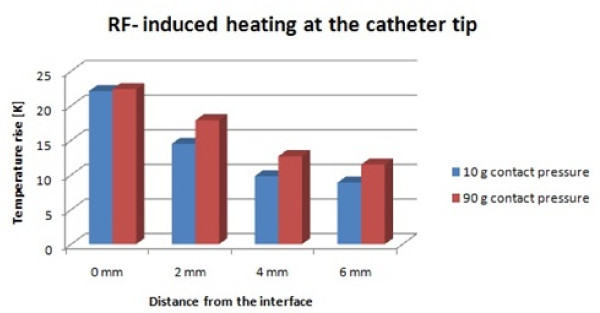
MR-RF induced heating at the catheter tip. The difference in the temperature rise at different contact pressures increases with tissue depth.